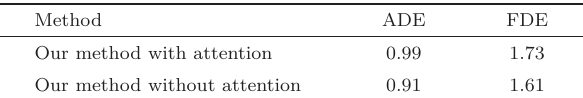
Table 2 Results with and without an attention mechanism, using the ETH dataset without data augmentation